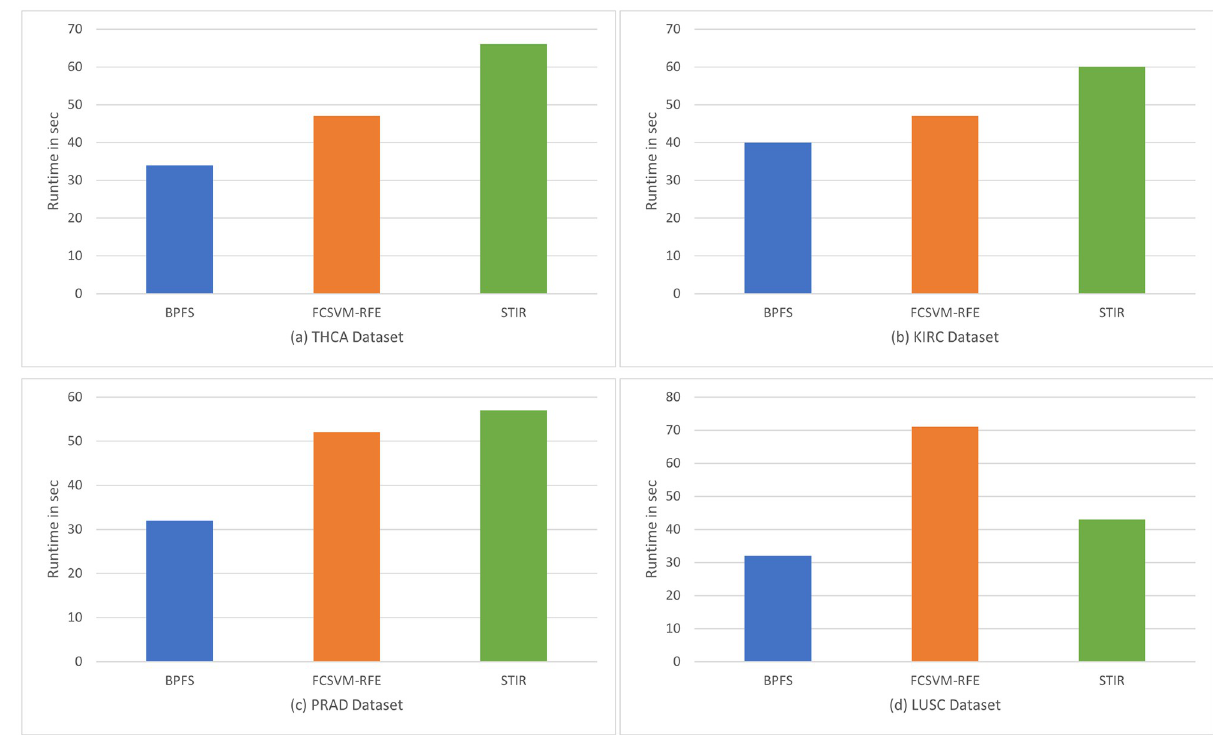
Fig 3. Runtime comparisons on four